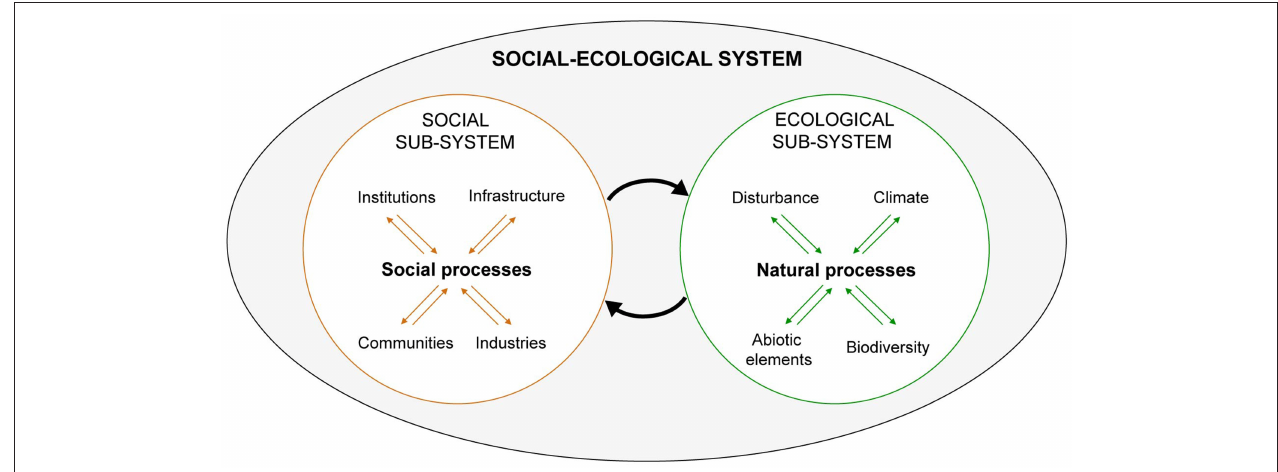
FIGURE 1 | Graphical representation of a social-ecological system. The large oval represents an entire social-ecological system including its component social and ecological subsystems. The two large arrows in the middle represent interactions between them. For example, the arrow targeting the ecological sub-system represents human influences on nature. These are the outcome of processes influenced and/or driven by citizens, commercial interests, institutions (rules, regulations, customs), and the human-built infrastructure. They impact the ecological sub-system in numerous and often invisible ways mediated through ecosystem processes and functions, as a result of myriad abiotic and biotic interactions. The arrow targeting the social sub-system represents the outcome of all these factors. Adapted from Chapin et al. (